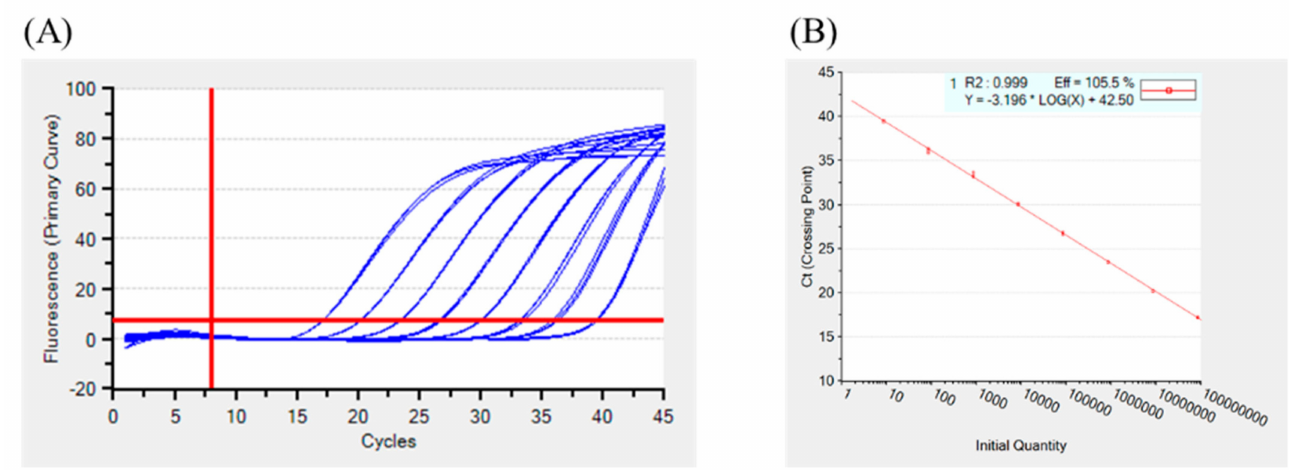
Figure 1. Analysis of a TaqMan-based real-time PCR assay performed in triplicate on aliquots of plasmid DNA (pDNA) containing the Megalocytivirus major capsid protein ( MCP ) gene, serially diluted 10-fold (8.6 × 10 7 to 8.6 copies/reaction). ( A ) Amplification plots of the real-time PCR assay. ( B ) Standard curve derived by plotting the threshold cycle (C t ) values against the pDNA copy